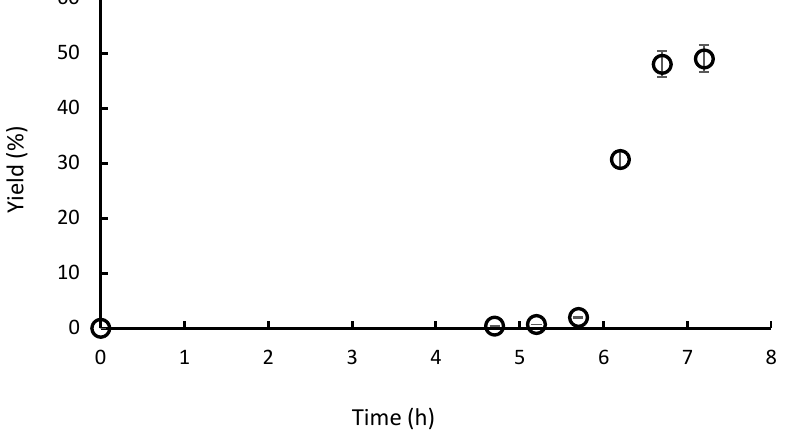
Figure 6. Chemoenzymatic synthesis of FDCA in a continuous packed-bed bioreactor catalyzed by Novozym 435 with two feeds. Reaction conditions: 30 °C, 5 mL of ethyl acetate at 50 mM of DFF at 10 µL/min, and 511µL of H 2 O 2 at 1 µL/min.